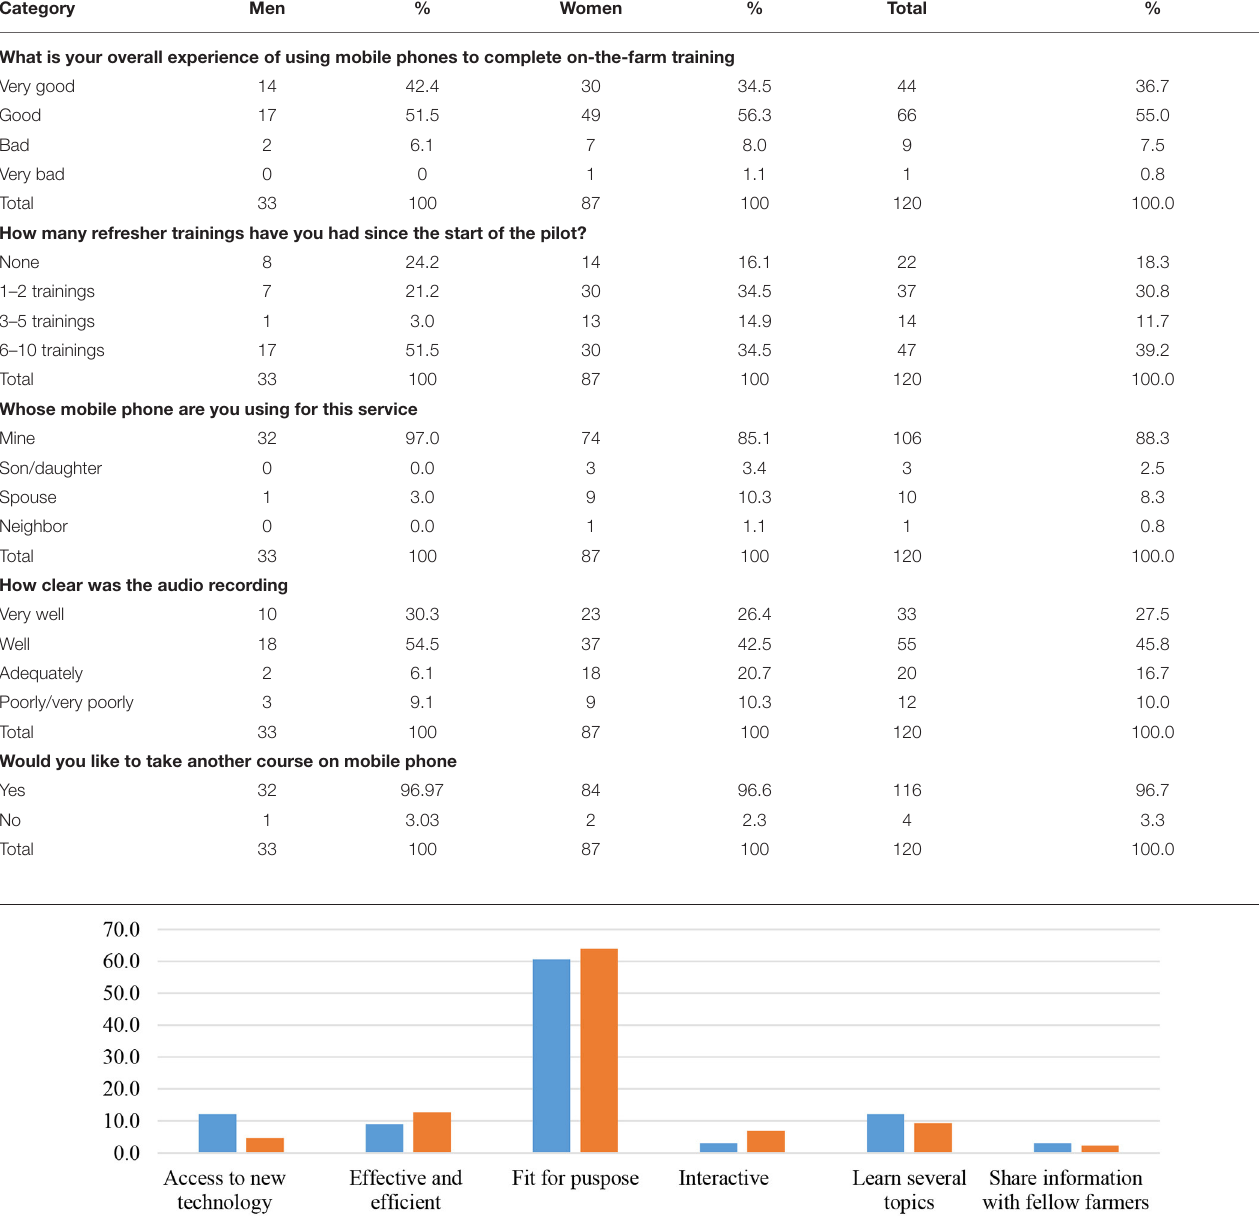
TABLE 5 | Responses of farmers to the evaluation survey. Category Men % Women % Total %